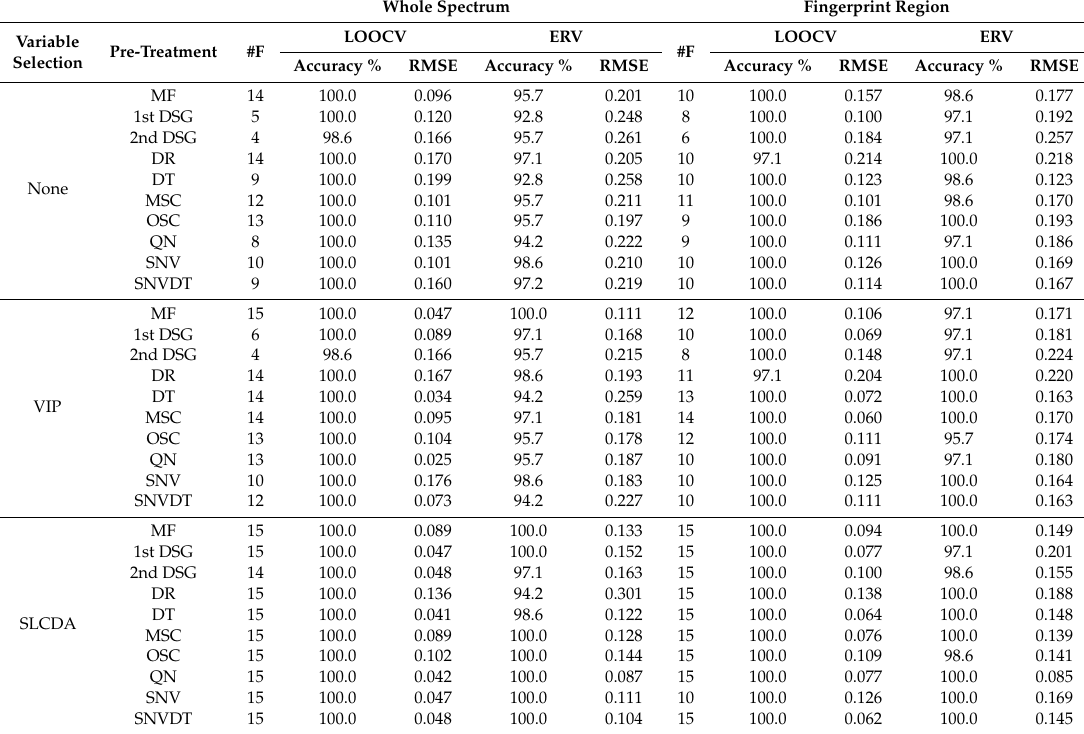
Table 1. Results from partial least squares discriminant analysis (PLS-DA) models applied to spectral transformations of attenuated total reflection mid-infrared (ATR-FT-MIR) spectra and variable selection procedures. (MF = Median Filter, 1st = Savitzky–Golay first derivative, 2nd = Savitzky–Golay second derivative, DR = De-resolve, DT = De-trend, MSC = Multiplicative Scatter Correction, OSC = Orthogonal Signal Correction, QN = Quantile Normalise, SNV = Standard Normal Variate, SNVDT =